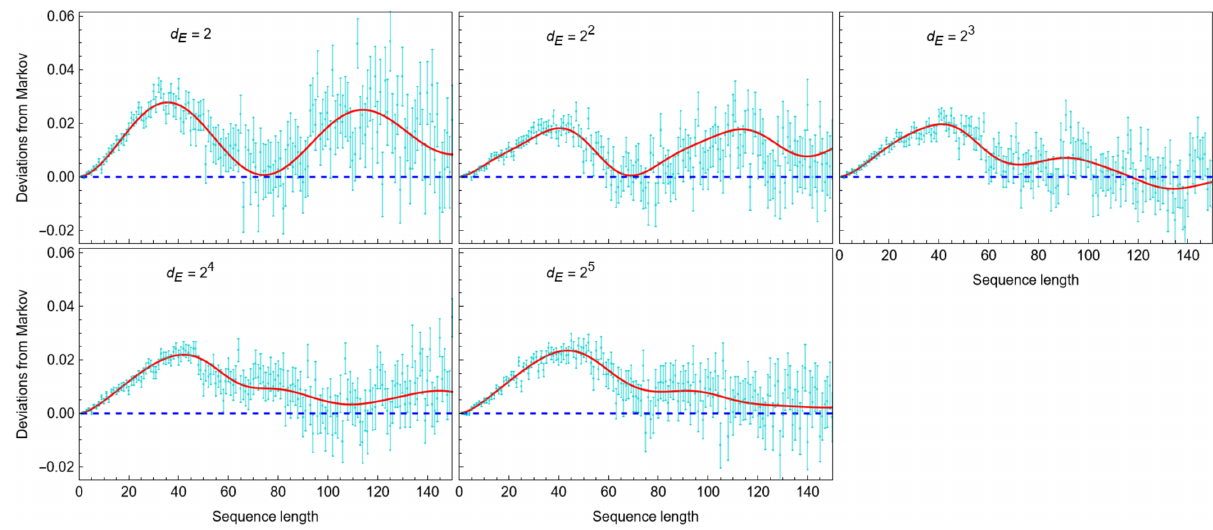
FIG. 14. Behavior of the ASF in environment dimension for an Ising spin chain as time-independent noise. We take as time- independent noise Eq. (G1) for a single qubit in S and a variable number of qubits in E , with site i = 1 being system S . For all we pick J = 1.7, h x = 0.9, and h y = − 1.05, fixing δ = 0.029 475 and take ρ = | 0 (cid:8)(cid:9) 0 | ⊗ 3 and M = | 0 (cid:8)(cid:9) 0 | , ignoring SPAM